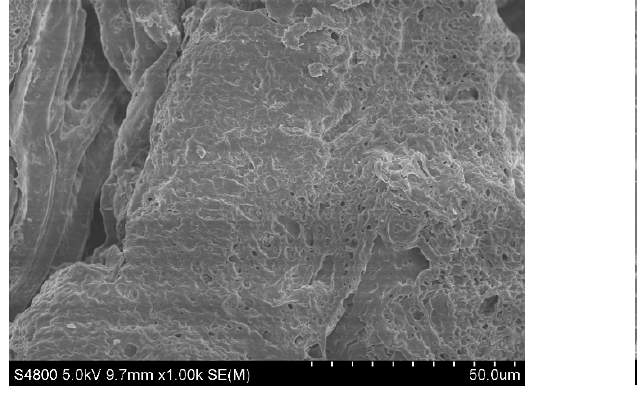
Figure 3. The scanning electron microscopy (SEM) images of ( a ) PCB and ( b ) HB.